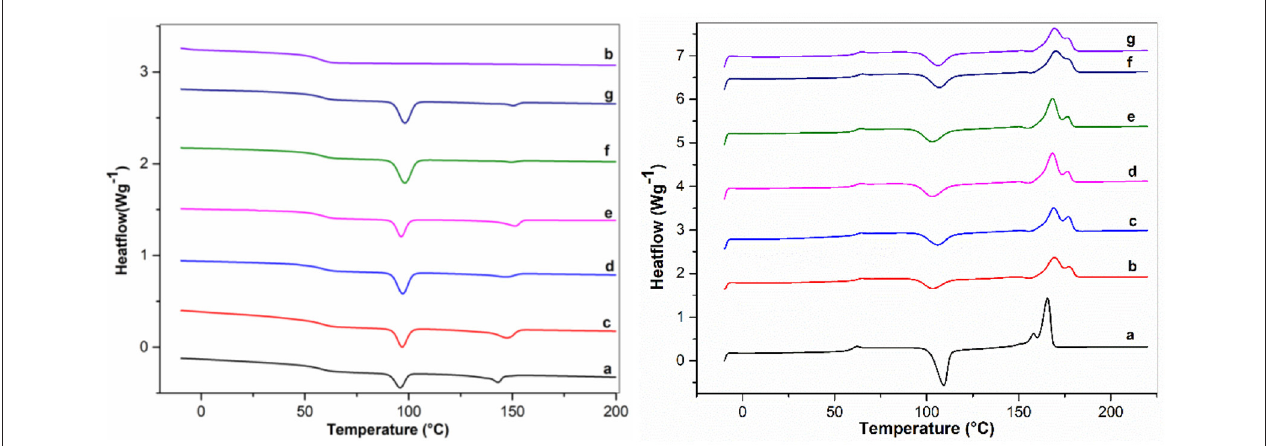
FIGURE 11 | DSC cooling (left) and heating (right) thermogram of PLA/PA12 blends with